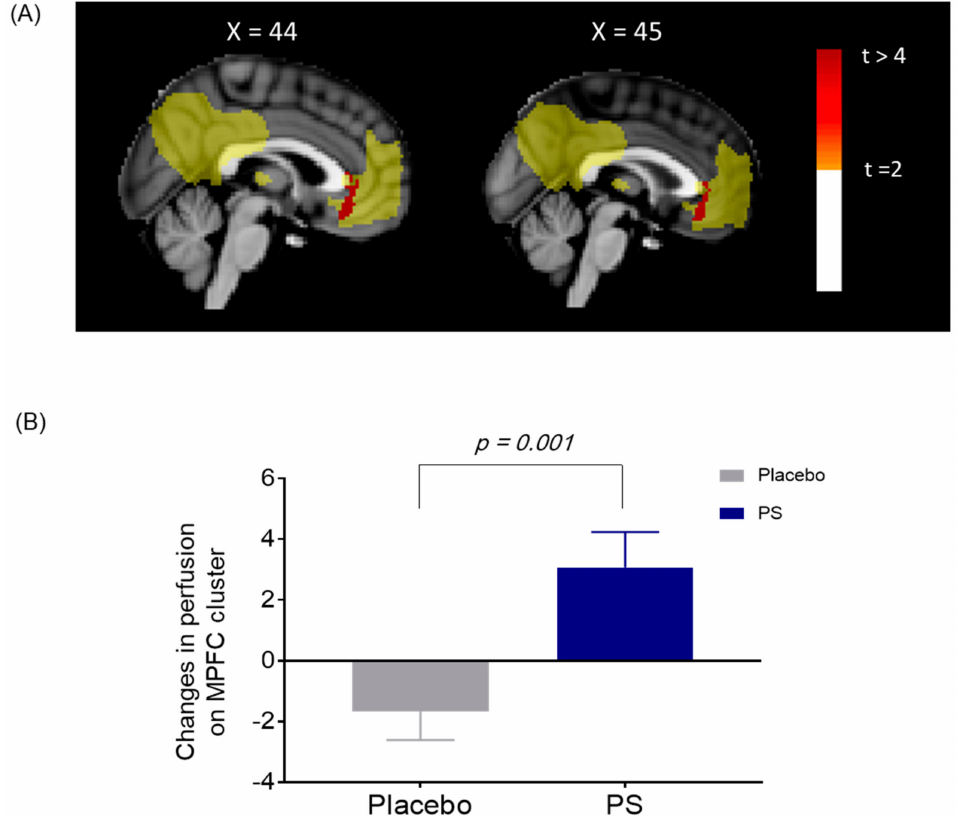
Figure 4. ( A ) Changes in cerebral perfusion on the default mode network (DMN) between the PS and placebo group. Significant between-group di ff erences in changes in cerebral perfusion within the medial prefrontal cortex (mPFC) of the DMN was shown after the four-week administration period (shown in red). ( B ) Increased cerebral perfusion on the mPFC in the PS group. The values were extracted from the mPFC for post-hoc analysis, which were significant clusters as shown in Figure 4 (A). Cerebral perfusion of the mPFC increased in the PS group, while decreased in the placebo after the four-week administration ( z = − 3.0, p for group-by-visit interaction = 0.001). mPFC, medial prefrontal cortex; PS, Polygonatum